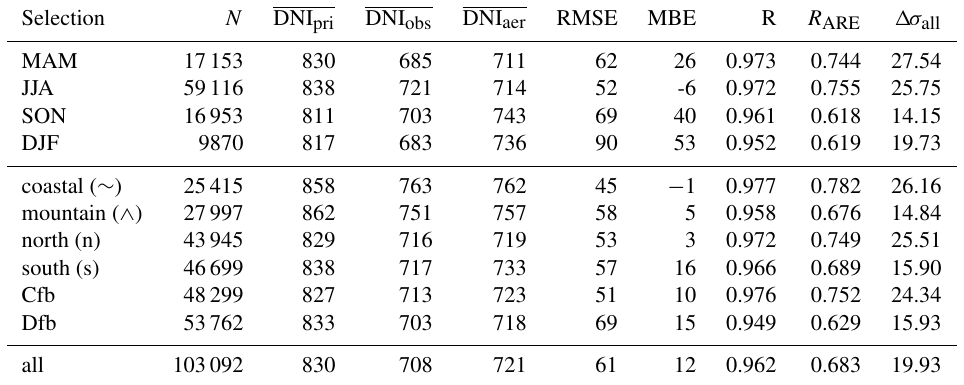
Table 5. T–CARS direct normal irradiance with aerosols (DNI aer ) and in pristine conditions (DNI pri ) compared to DWD observations (DNI obs ). Annual average values are represented by an overline (e.g. DNI). The RMSE and MBE are shown for the comparison of DNI aer and DNI obs . Correlations are shown for R( DNI obs , DNI aer ) and R ARE ( DNI obs − DNI pri , DNI aer − DNI pri ) . The level of agreement is evaluated by the difference of the SD of simulations in pristine conditions and with aerosols using Eq. (9) ( (cid:49)σ all ).